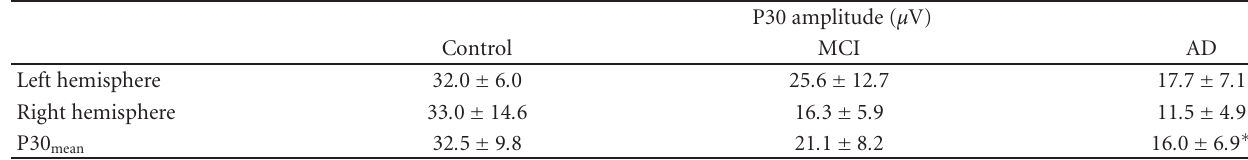
Table 1: Group-wise values of P30 amplitude.